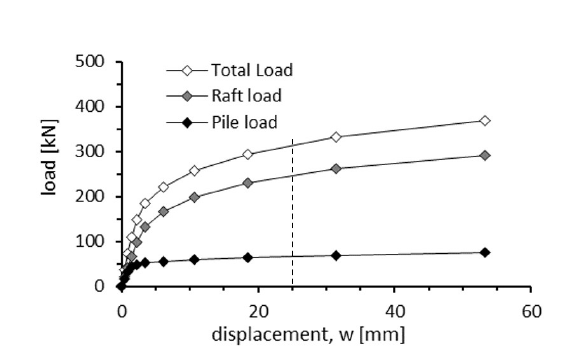
Figure 10. Load-settlement curves for case 3 - L=3m; t=0.3m